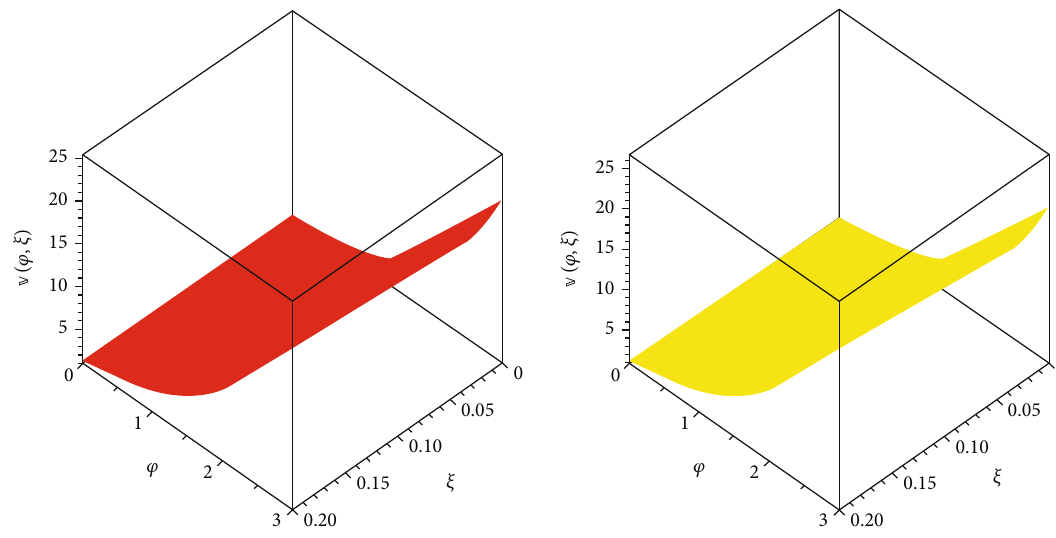
Figure 7: (a) ℘ = 1 and (b) the fractional-order ℘ = 0 : 8 of Example